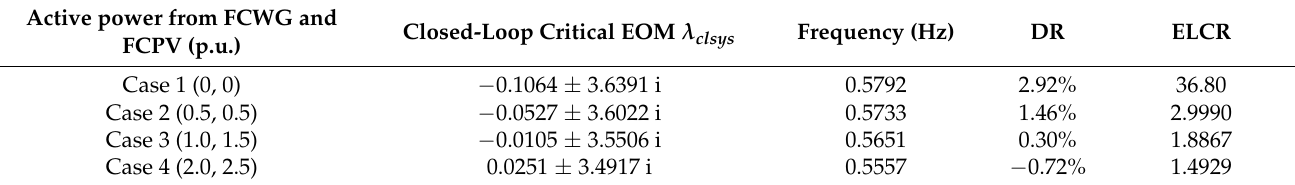
Table 2. Closed-loop modal analysis regarding different renewable energy penetration levels. Active power from FCWG and FCPV